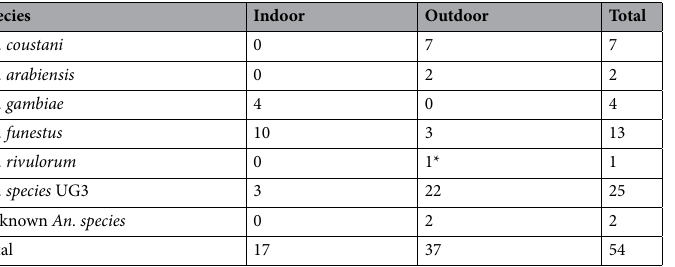
Table 2. Composition of sample of adult female Anopheles from western Zambia after 2019 wet season peak. Species identities based on above-threshold matches to COI and/or ITS2 DNA sequences on GenBank. ‘Unknown An. species ’ denotes specimen whose sequence matched to Anopheles reference sequences, below 95% similarity threshold. *Sex unknown as morphological characters missing from damaged specimen.